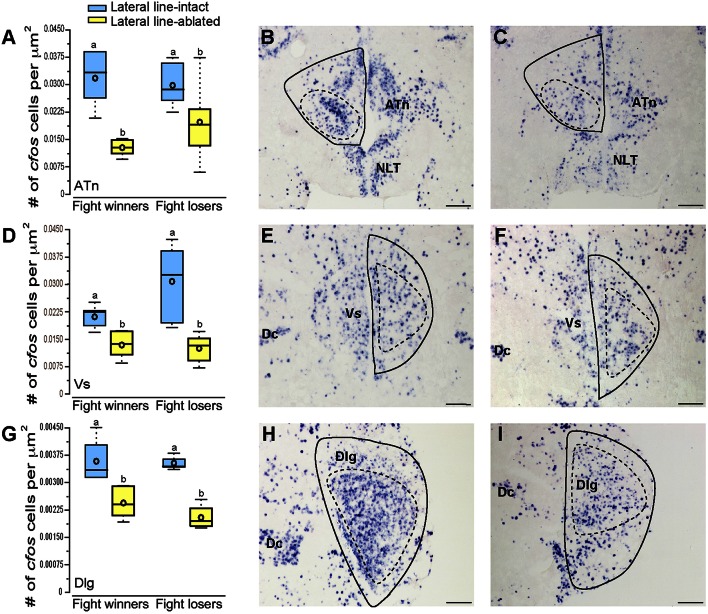
Lateral line-ablated animals have decreased cfos staining in several SDMN nuclei. Quantification of cfos staining in the ATn (A), Vs (D), and Dlg (G) in lateral line-intact (blue) and -ablated (yellow) fight winners and losers (N = 6 for all groups). Photomicrographs of representative cfos staining (dark blue label) in transverse sections through the ATn of a lateral line-intact (B) and -ablated (C) animal, the Vs of an intact (E) and ablated (F) animal, and the Dlg of an intact (H) and ablated (I) animal. Solid circles depict nuclei borders and dashed outlines represent the subarea quantified for each nucleus. Different letters indicate statistical significance at P < 0.05 using post-hoc LSD tests. Scale bars in (B,C,E,F,H, I) represent 100 μm. See Figure 1 legend for box plot descriptions. See list for abbreviations.